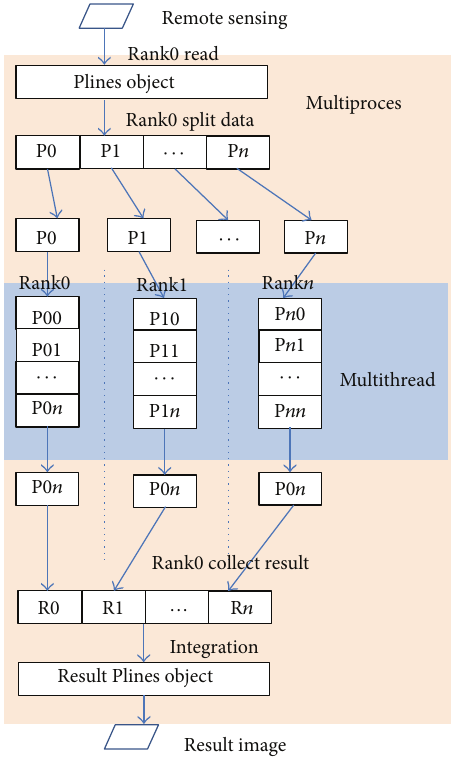
Figure 2: Plines object and its status at different stage.